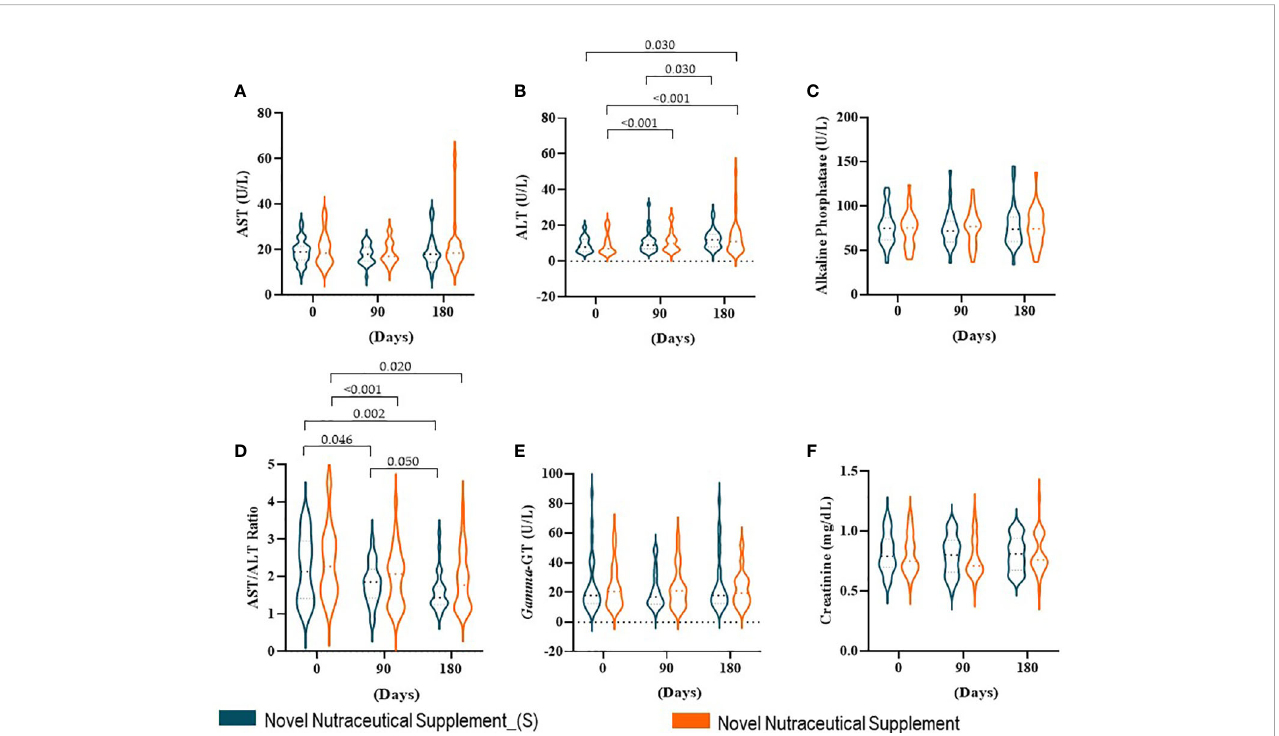
FIGURE 3 Liver enzymes, AST/ALT ratio (AAR), and creatinine at baseline time (Day 0) and 90 and 180 days post-supplementation. (A) AST. (B) ALT. (C) Alkaline phosphatase. (D) AAR. (E) Gamma-GT. (F) Creatinine. Novel Nutraceutical Supplement_(S) (n = 30) and Novel Nutraceutical Supplement (n = 29). Values are expressed as mean ± SEM or median (min to max, box plot) by plot violin graphic. AST, aspartate aminotransferase; ALT, alanine aminotransferase; gamma-GT, gamma-glutamyl